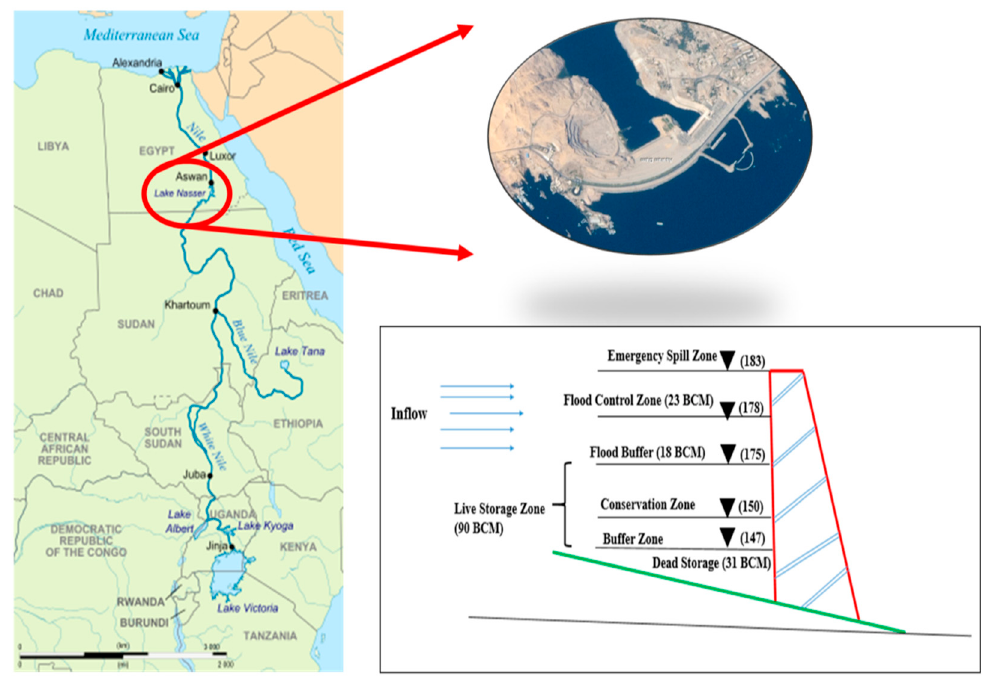
Figure 5. Location and characteristics of Aswan High Dam.